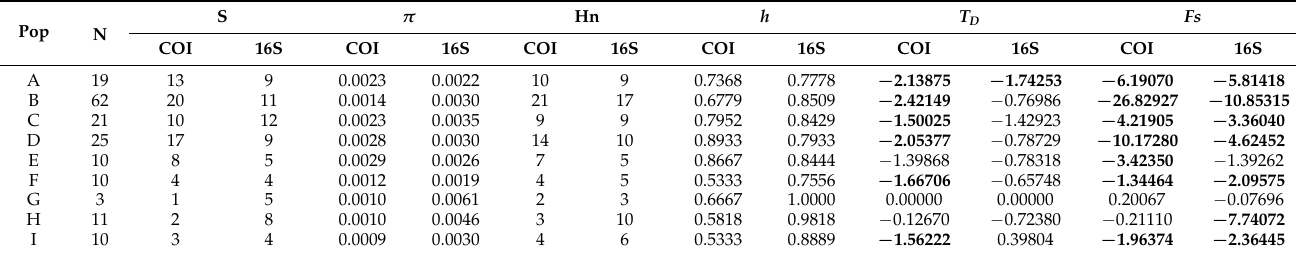
Table 3. Genetic diversity and neutrality test of COI and 16S rRNA genes in populations of the hilly lineage of NSC.